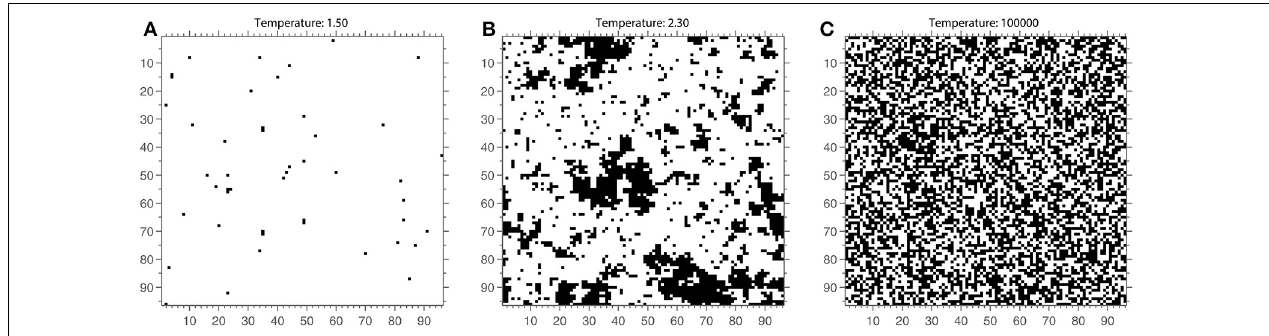
FIGURE 2 | TheIsingmodellatticeatasingletimepointoncesteadystate has been reached for 3 different values of the temperature parameter. (A) TheIsinglatticeatacoldtemperatureof1 . 5.Almostallspinsarealigned(white) and there is little change across time. (C) The Ising lattice at a high temperature